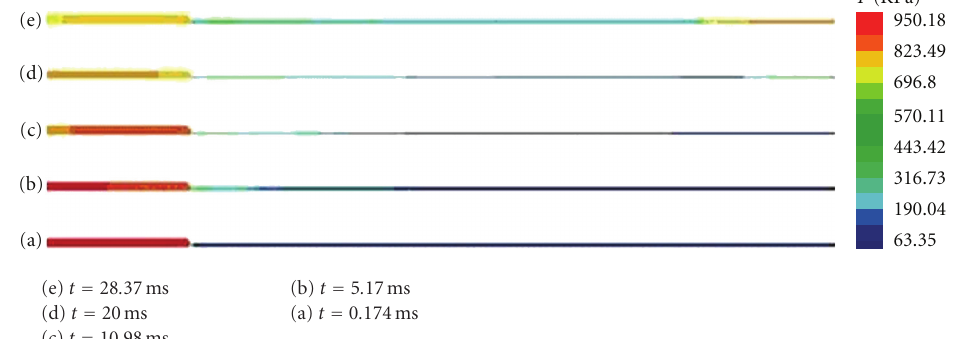
Figure 5: Snapshots of the pressure distribution in the tube.